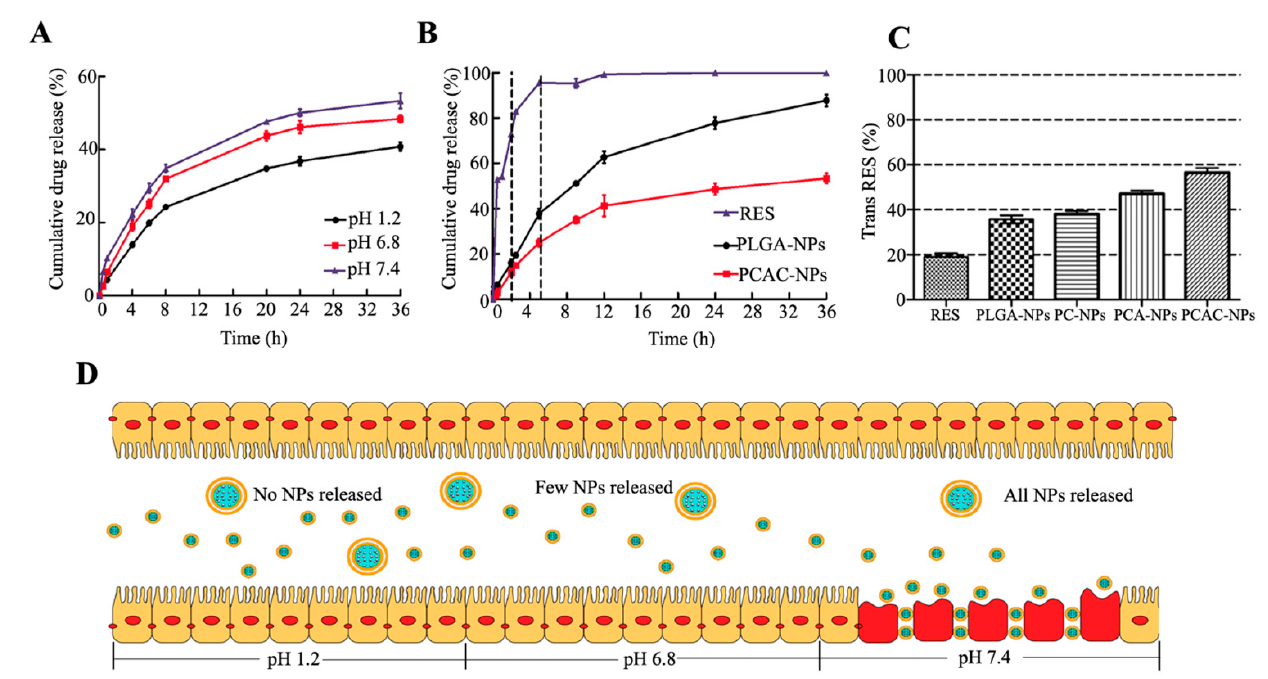
Figure 4. In vitro drug release: ( A ) Release curves of PCAC-NPs at pH 1.2, pH 6.8 and pH 7.4, respectively. ( B ) Release curves of RES, PLGA-NPs and PCAC-NPs in simulated digestive system. ( C ) Retention percentage of RES, PLGA-NPs, PC-NPs, PCA-NPs and PCAC-NPs exposed to ultraviolet light for 120 min. ( D ) Schematic simulation of PCAC-NPS from entering the gastric environment to being adsorbed to the inflammatory site of the colon. (In the simulated gastric environment at pH 1.2, almost no NPs release drugs. Then, the NPs enter the simulated small intestine environment at pH 6.8, and a few NPs begin to release drugs. Finally, the NPs enter the simulated colon at pH 7.4, and most of the NPs adhere to the site of inflammation and all NPs release drugs.)